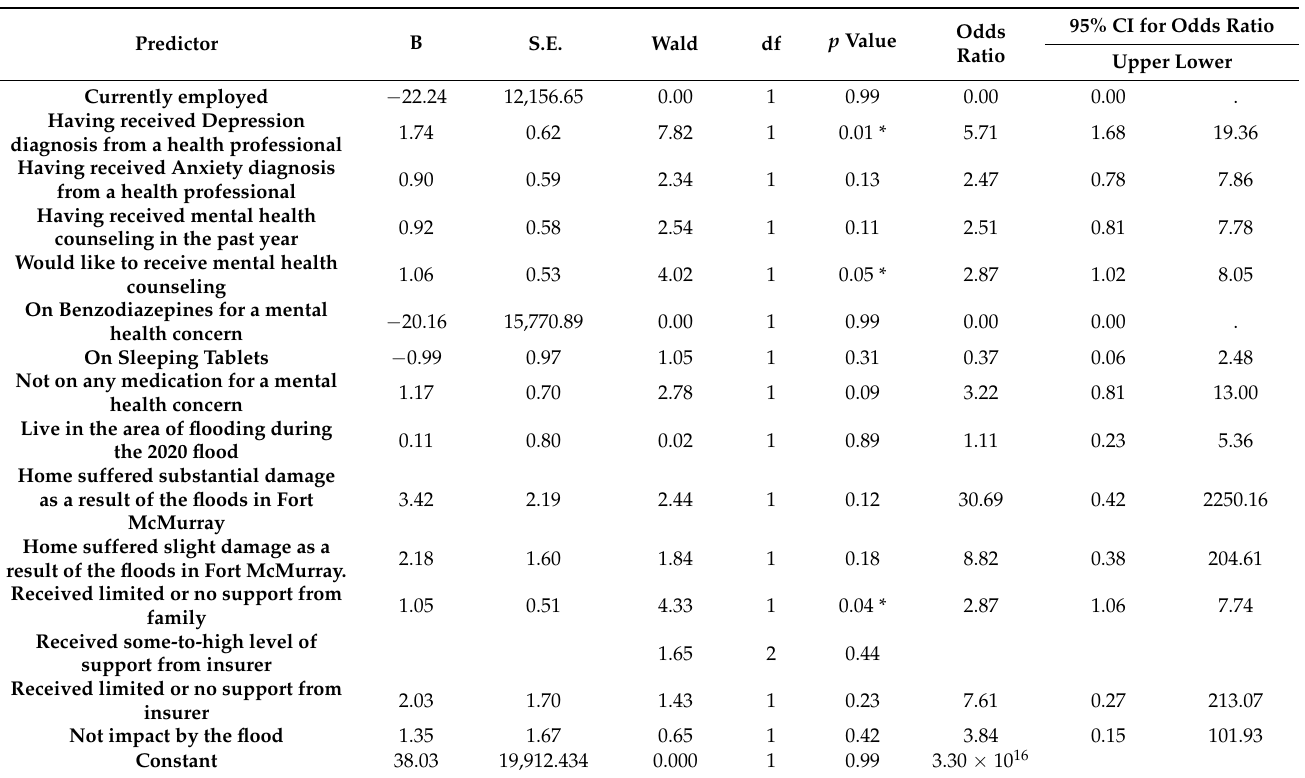
Table 3. Logistic regression predicting likelihood of residents presenting with